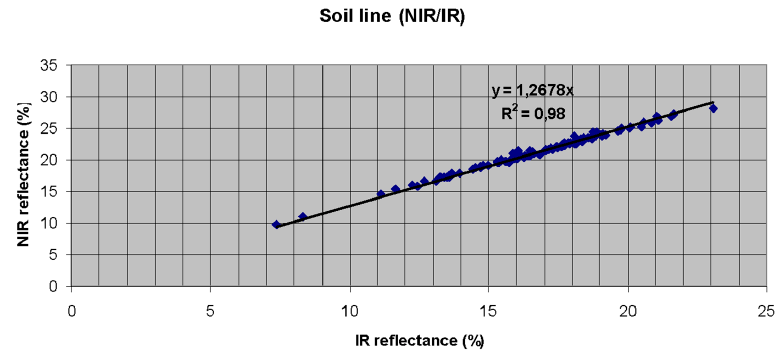
Figure 4. Soil slope line for WDVI of the area of interest.